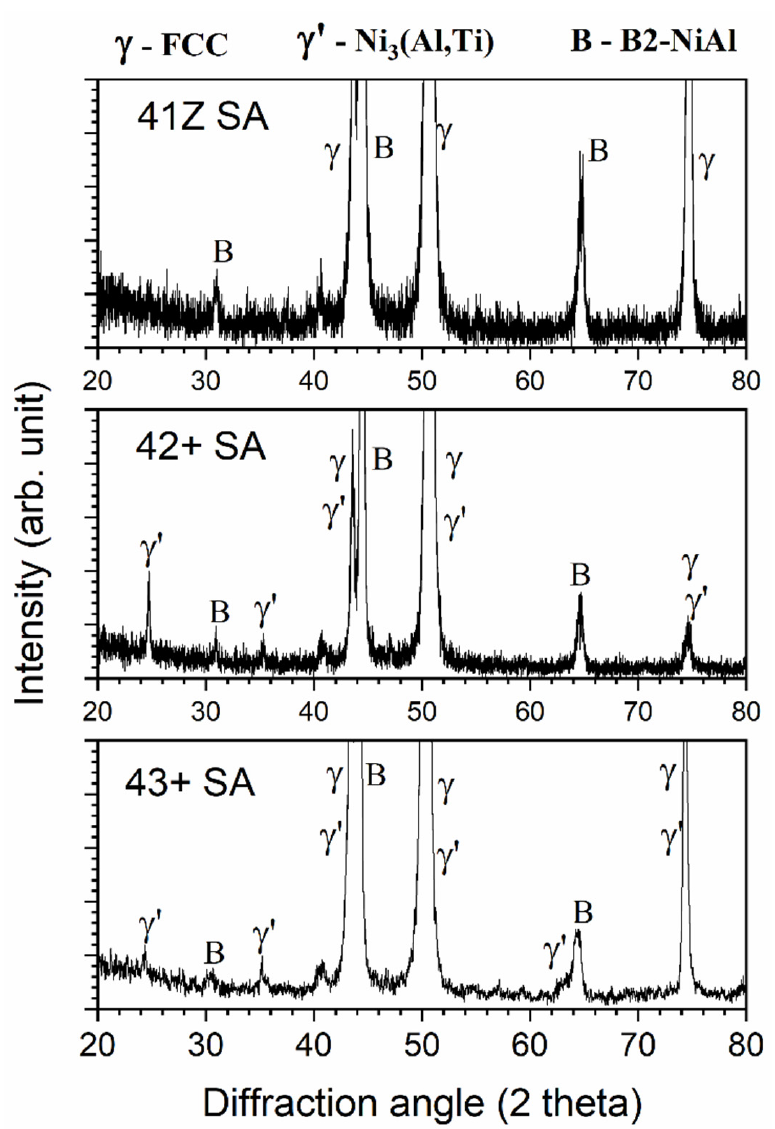
Figure 8. XRD results for the alloys 41Z SA, 42+ SA, and 43+ SA after the creep test in air at 750 °C and 150 MPa.